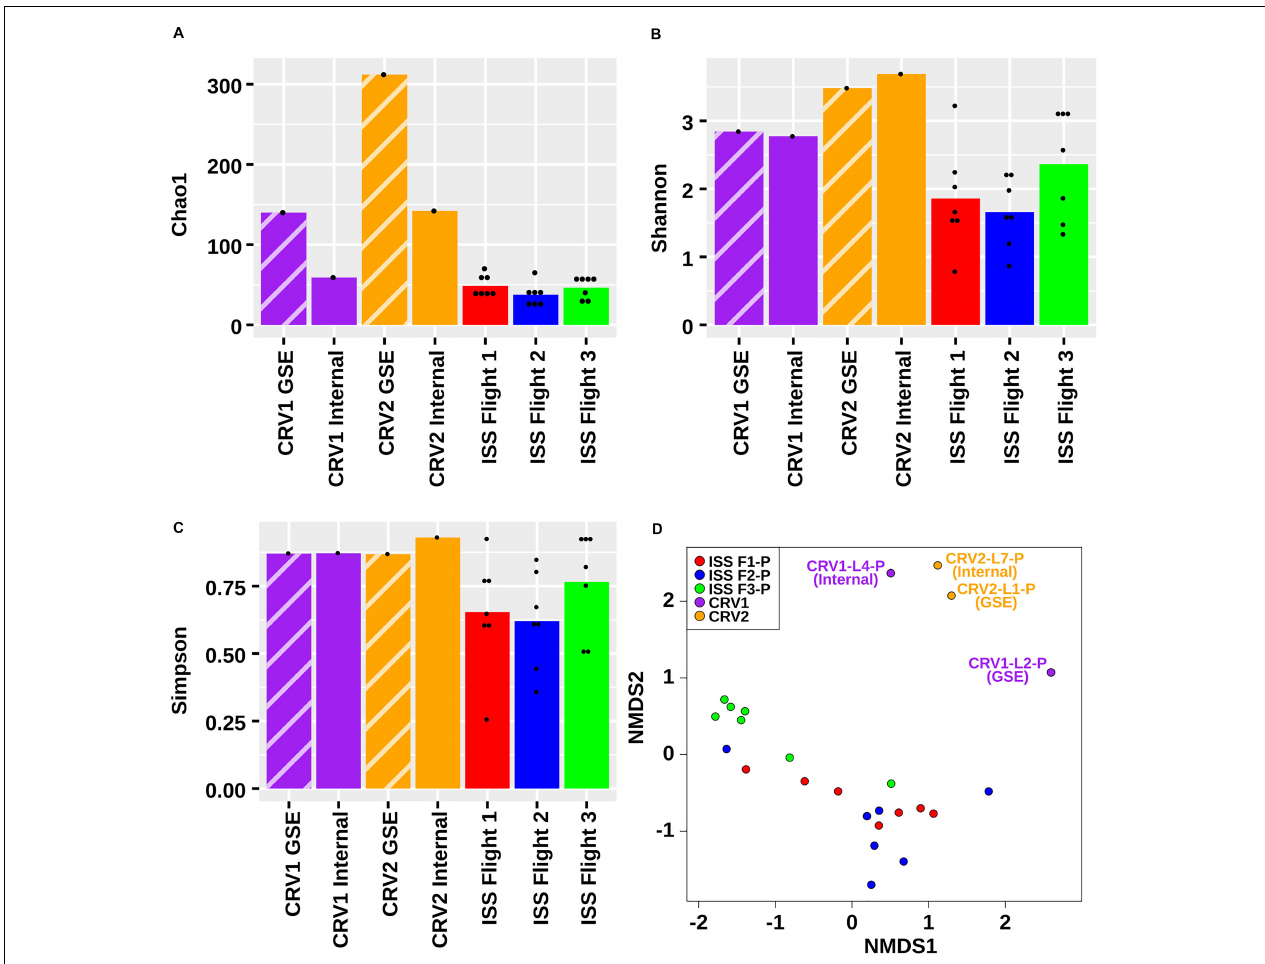
FIGURE 6 | Chao1 (A) , Shannon (B) , Simpson (C) , and NMDS (D) plots representing the differences in the microbial diversity detected from metagenomes generated from PMA treated samples collected from the internal (I) and ground support equipment (GSE) surfaces of CRV1, CRV2 and the locations from three sampling events of the